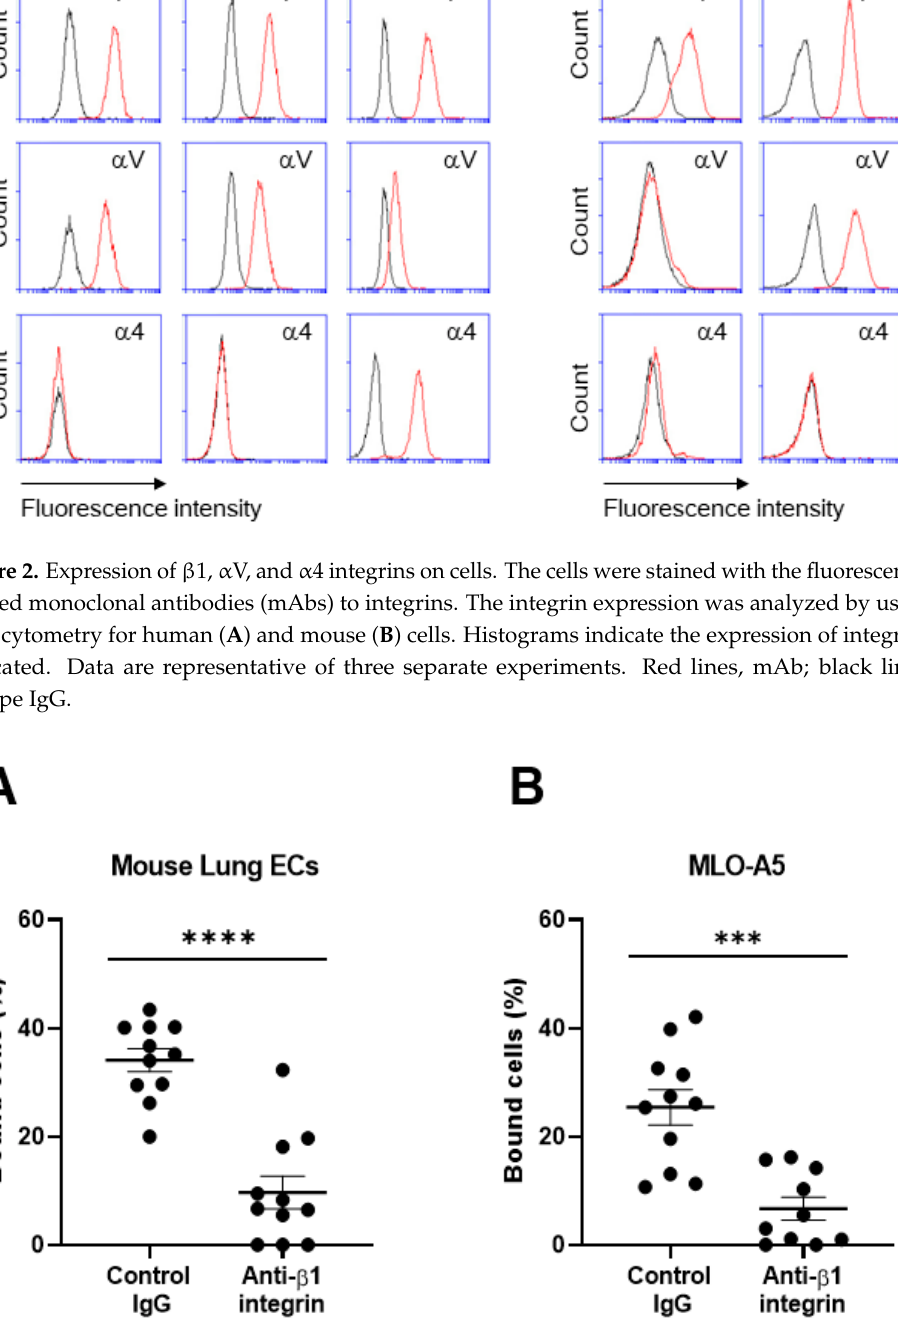
Figure 3. Binding of the SARS-CoV-2 spike (S1) protein to mouse primary lung cells ( A ) and osteo- clastic MLO-A5 cells ( B ). Results are shown as column scatterplots overlayed with the mean ± SEM of at least 3 independent experiments, in which each sample was triplicated. *** p < 0.001; and **** p < 0.0001.